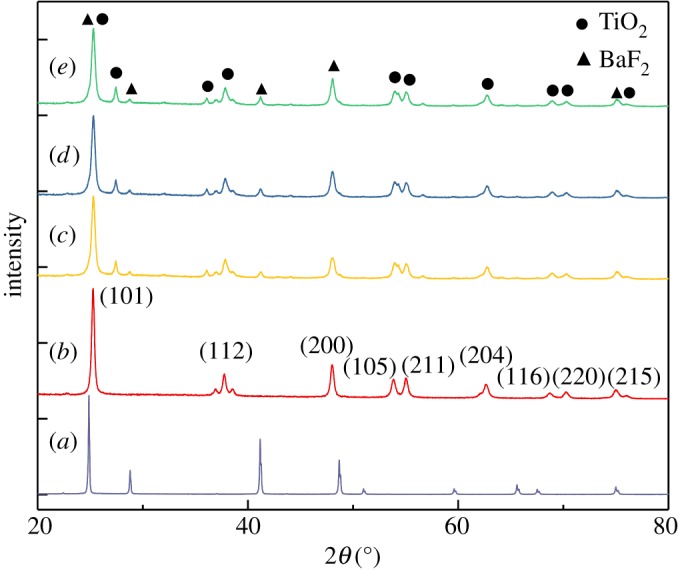
XRD patterns of (a) BaF2, (b) TiO2, (c) BaF2–TiO2 (0.35-BaF2–TiO2), (d) BaF2–TiO2 (0.75-BaF2–TiO2) and (e) BaF2–TiO2 (1.5-BaF2–TiO2).